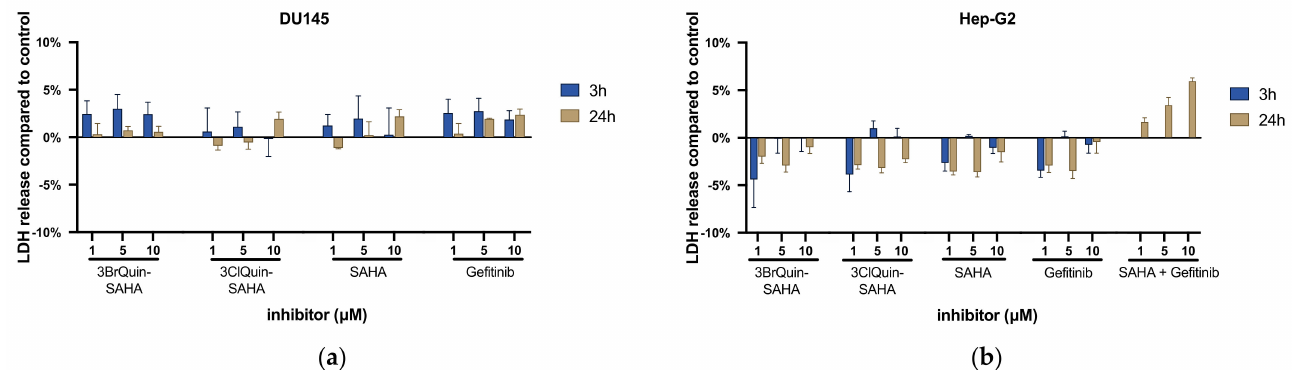
Figure 2. Unspecific cytotoxic effects of 3BrQuin-SAHA and 3ClQuin-SAHA in ( a ) prostate cancer and ( b ) hepatoma cells. LDH release of DU145 and Hep-G2 cells was measured after 3 and 24 h of incubation with 1, 5, or 10 µ M of 3BrQuin-SAHA or 3Cl-Quin-SAHA, as well as SAHA and gefitinib alone or in combination on Hep-G2 cells. Results show changes in LDH release relative to untreated controls. Data are given as percentage changes relative to basal LDH release of controls. Means ± SEM of n = 3 independent